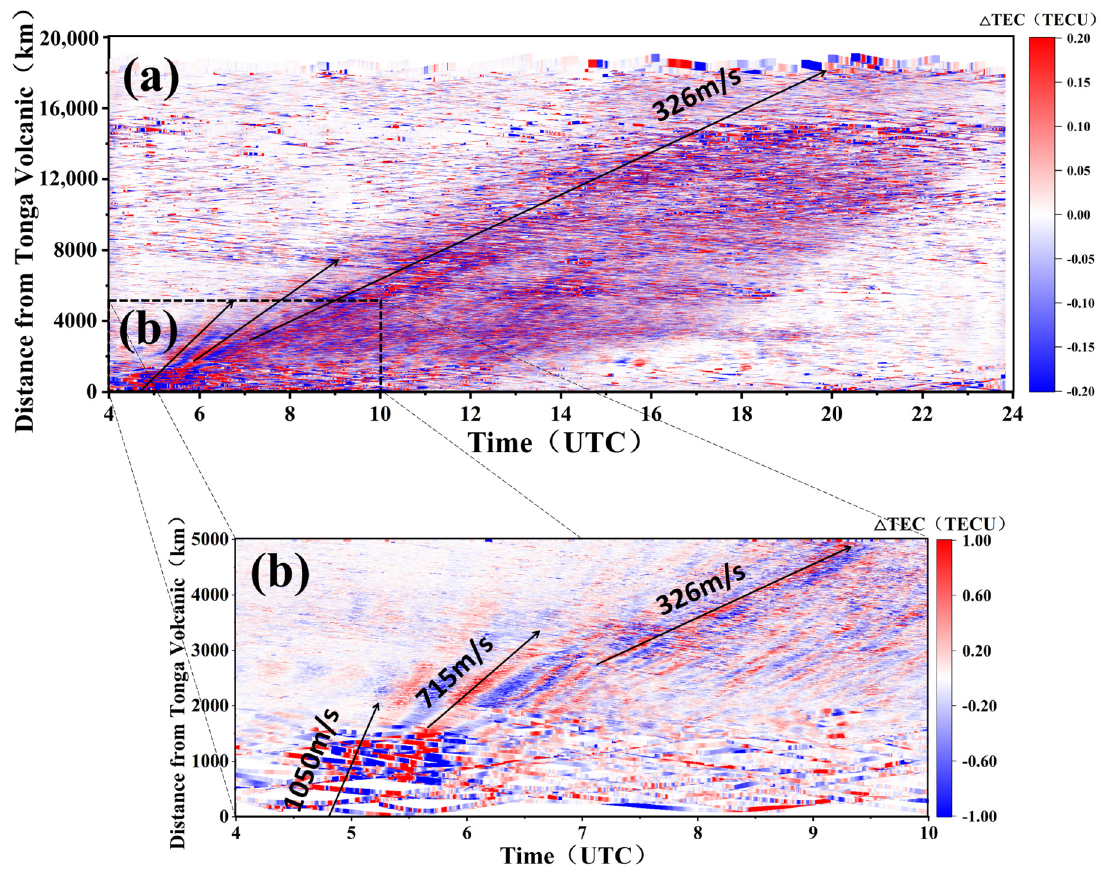
Figure 3. Distance-time analysis of TID propagation at 450 km altitude on the day of the Tonga eruption ( a ) TID propagation in the near-field within 5000 km ( b ) TID propagation in the global 18,000 km range.